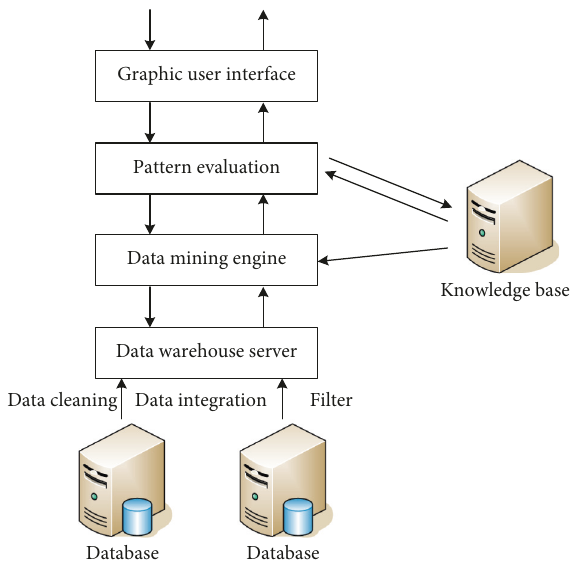
Figure 5: Knowledge recognition system